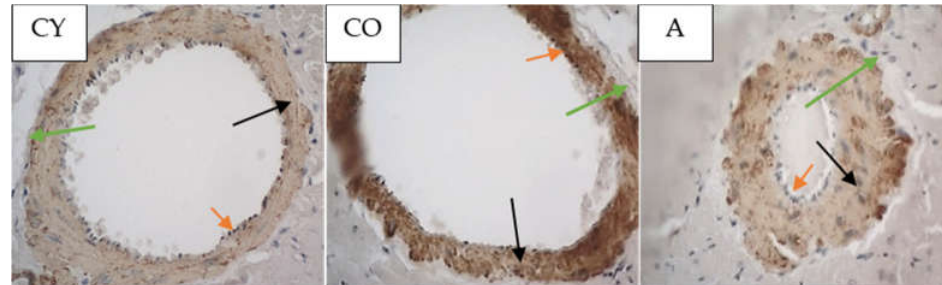
Figure 4. Myocardium. Coronary arteries of left ventricle of rat heart, αSMA immunoreaction in tunica media, magnification ×400. Orange arrows indicate tunica intima, black arrows—tunica media, green arrows—tunica adventitia.